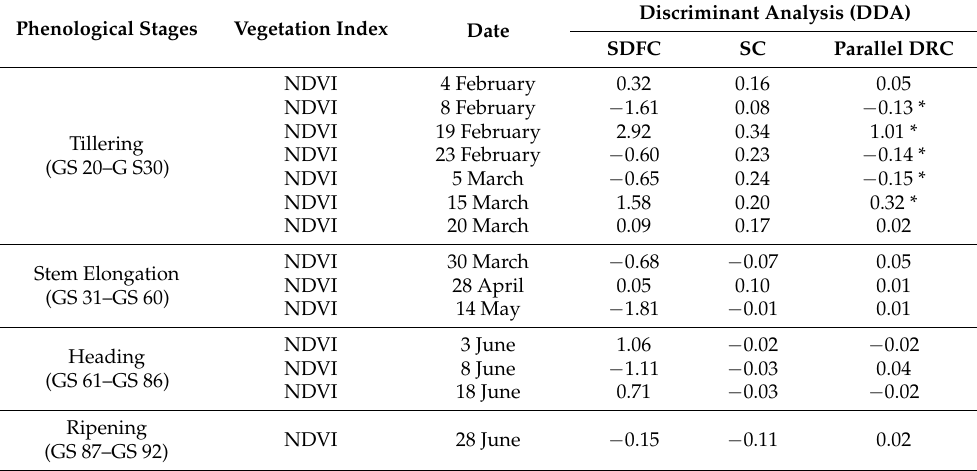
Table 6. Results of DDA after MANOVA being significative, showing contribution of NDVI values from different data to classification of the plots on the group with or without agreement among NDVI and